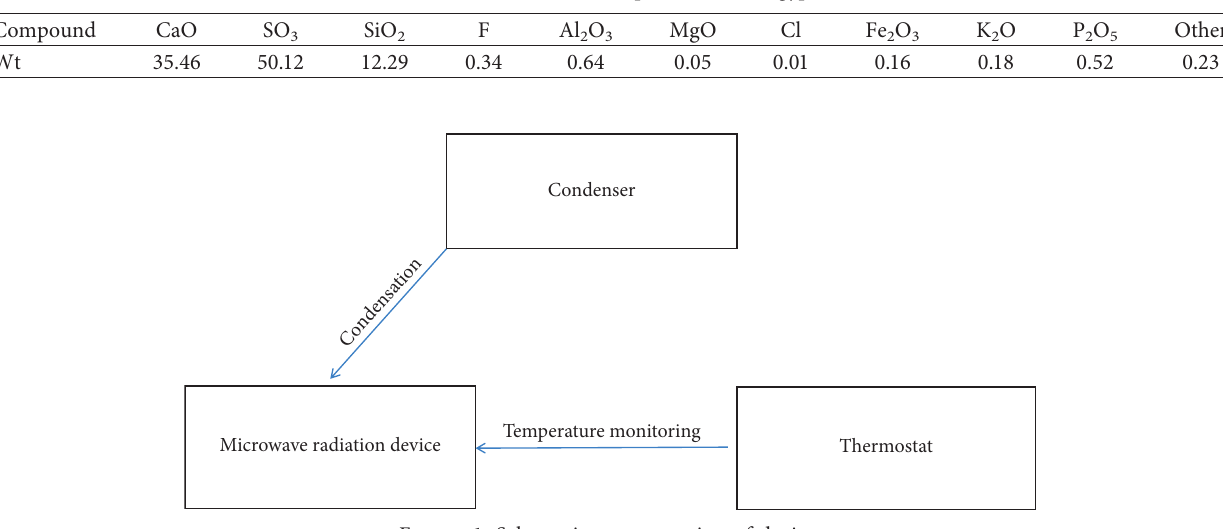
Table 1: The main chemical composition of PG gypsum